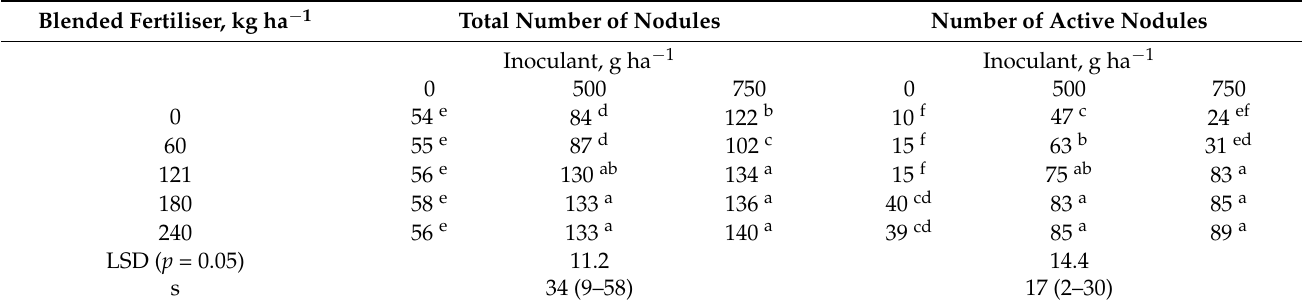
Table 6. Total number of nodules and active nodules per plant as affected by blended fertiliser and inoculant rate. Blended Fertiliser, kg ha − 1 Total Number of Nodules Number of Active Nodules Inoculant, g ha − 1 Inoculant, g ha −